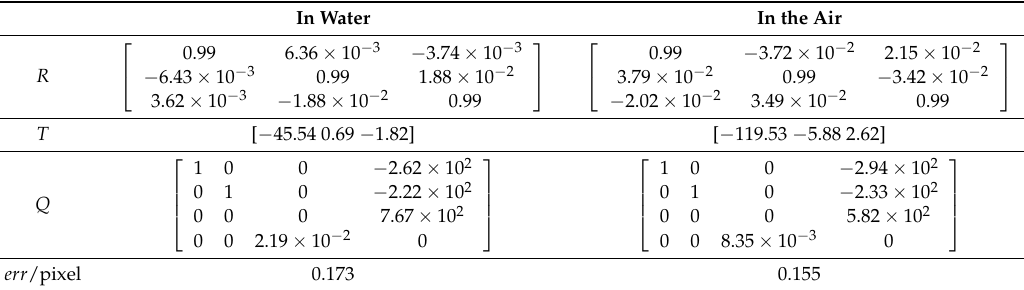
Table 3. External parameters of the binocular vision system (in water and in the air, at 1 m distance). In Water In the Air